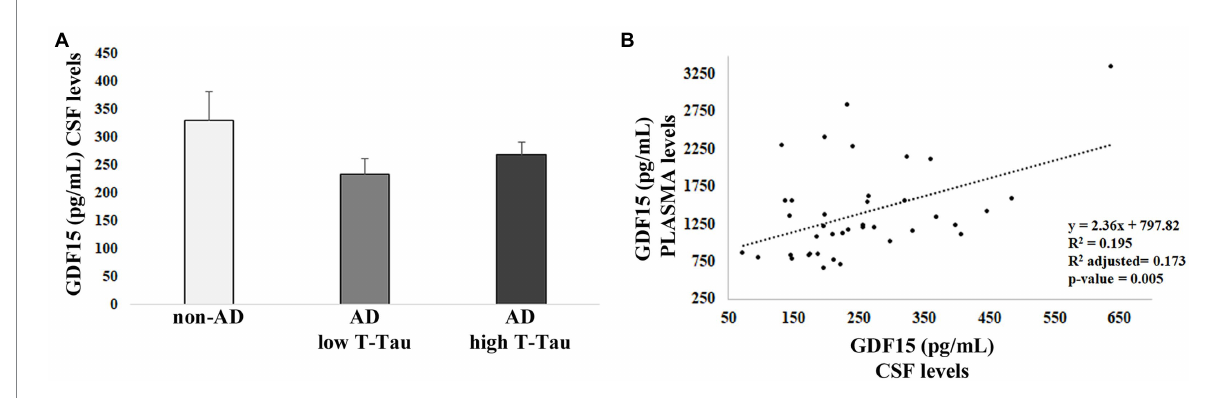
FIGURE 1 ELISA analysis of growth differentiation factor 15 (GDF15) levels in cerebrospinal fluid (CSF) and plasma. (A) GDF15 CSF level in 8 non-AD subjects (non-AD), 20 AD patients with low T-Tau CSF level [Alzheimer’s disease (AD) low T-Tau], and 20 AD patients with a high CSF T-Tau level (AD high T-Tau). (B) Regression analysis of GDF15 levels in CSF and plasma of the same